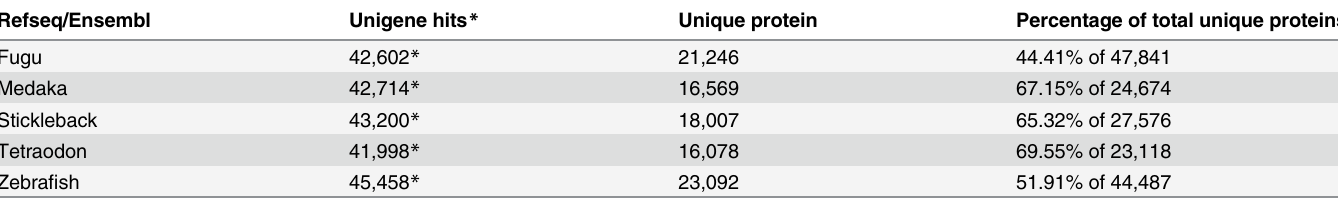
Table 2. Blast X search analysis of all transcripts of C . idella .